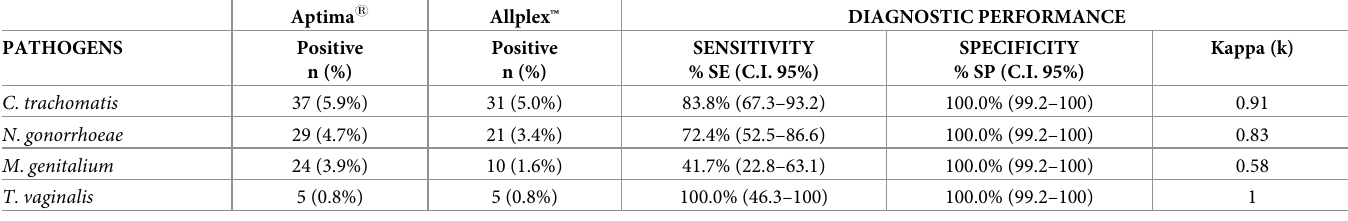
Table 2. Diagnostic performance of Allplex ™ STI Essential assays in relation to the Aptima 1 assays for C . trachomatis , N . gonorrhoeae , M . genitalium and T . vaginalis